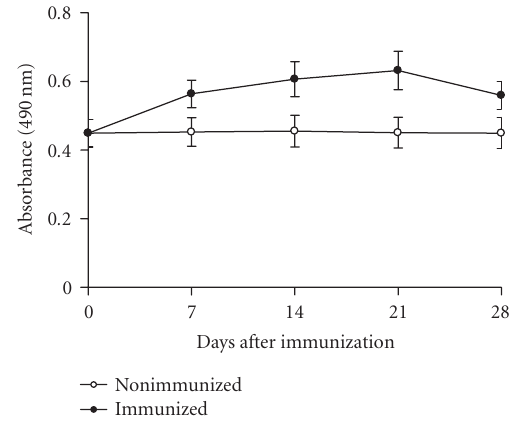
Figure 5: Antibody response in immunized mice. Immunizations were administered as described in Materials and Methods. Groups of mice immunized were bled on days 28 and the antiserum was tested on ELISA plates coated with CSV as described in “Materials and Methods.” The experiment was repeated twice and each point represents the value of pooled sera from 5 animals